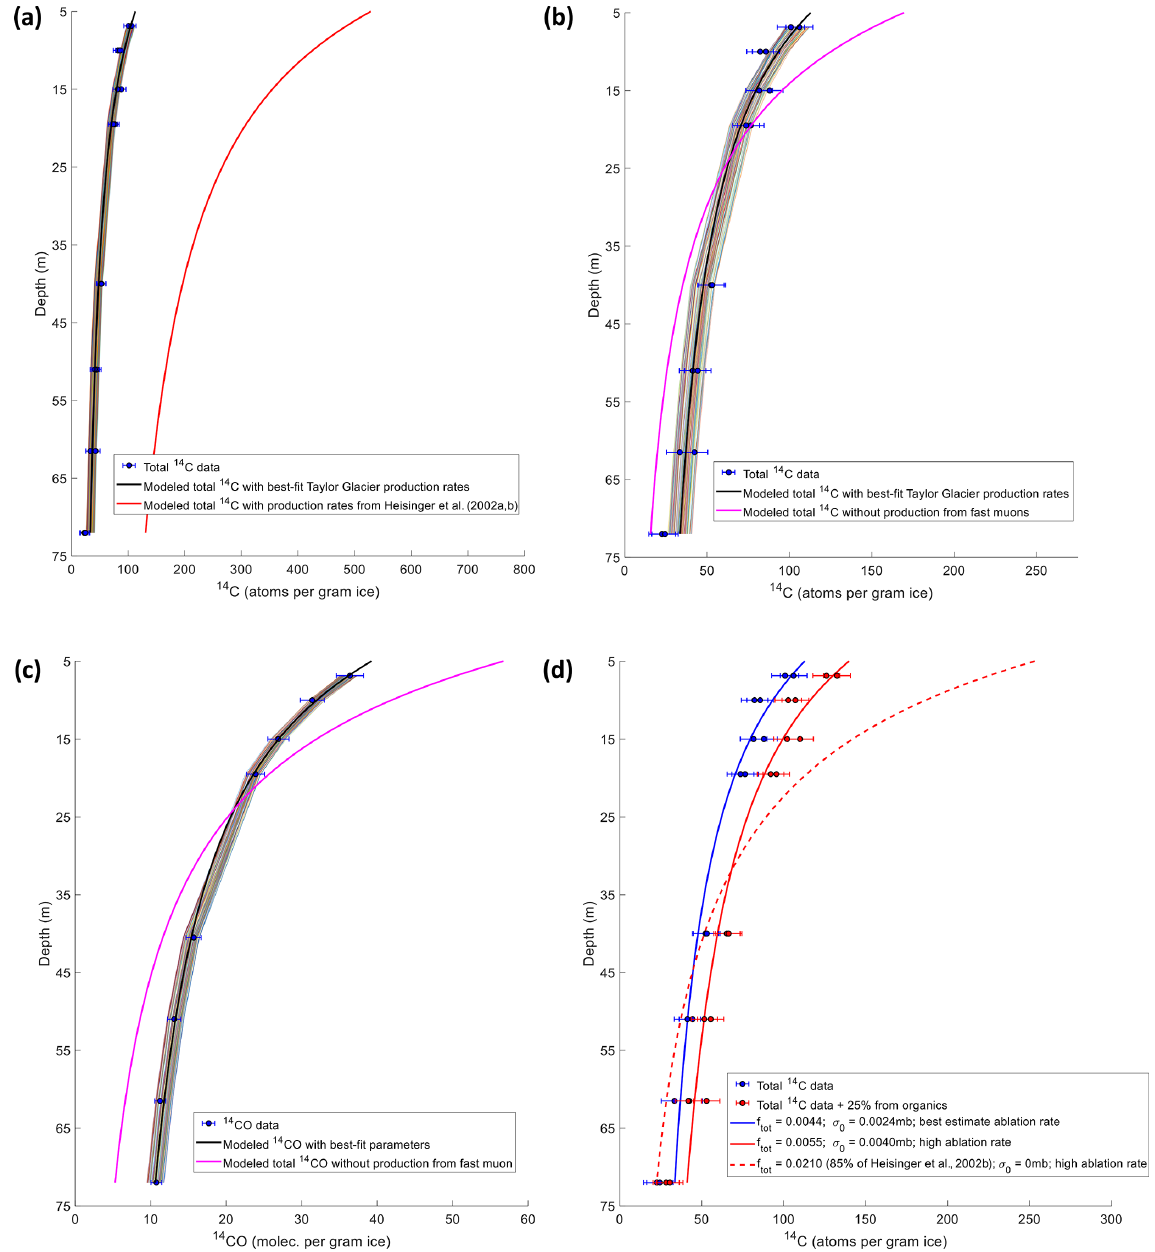
Figure 6. (a) Comparison between total 14 C measurements with modeled best-estimate σ 0 and f tot parameters from this study and Heisinger et al. (2002a, b). (b) Comparison between total 14 C measurements with modeled best-estimate σ 0 and f tot parameters from this study and modeled total 14 C with best-fit f tot when σ 0 is forced to be zero. (c) Comparison between 14 CO measurements with modeled best-estimate f neg and f fast parameters from this study and modeled 14 CO with best-fit f neg when f fast is forced to be zero. (d) Comparison between total 14 C measurements with modeled best-estimate σ 14 C from the sensitivity analyses 0 and f tot parameters from this study and modeled total when we assume 25% contribution from organics and high ablation rate scenario (Fig. S9). The thin colored lines represent the 95% CI envelope of the model results (corresponding to the contour plot of Fig. 7a for Fig. 6a and b and the contour plot of Fig. 7b for Fig. 6c). The error bars shown in the data are 95% CI. In Fig. 6d, the solid blue line represents the 14 C profile from the modeled best-estimate f tot and σ 0 under the best-estimate ablation rate. The solid red line represents the 14 C profile from the sensitivity analysis when f tot and σ 0 are tuned to fit the total 14 C data that are scaled by 25% to account for contribution from organics (red dots) under high ablation rate scenario (Fig. S9). The dashed red line represents the 14 C profile from the sensitivity analysis when f tot is kept constant at 0.021 (which is the minimum value provided by Heisinger et al., 2002b) and σ 0 = 0 (which provides the best-fit against the